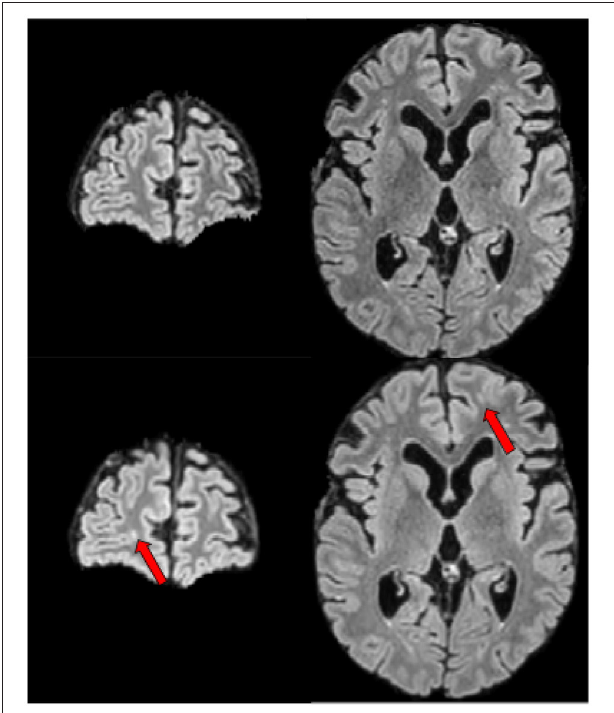
FIGURE 6 | Example of a lesion detected by none of the experts in the first phase of the experiment, detected by the segmentation module and accepted by all experts in the second phase of the experiment. First row shows the baseline FLAIR scan (from left-to-right: coronal and axial view), second row shows the FLAIR scan 1 year later (from left-to-right: coronal and axial view). Red arrows designate the lesion of interest.